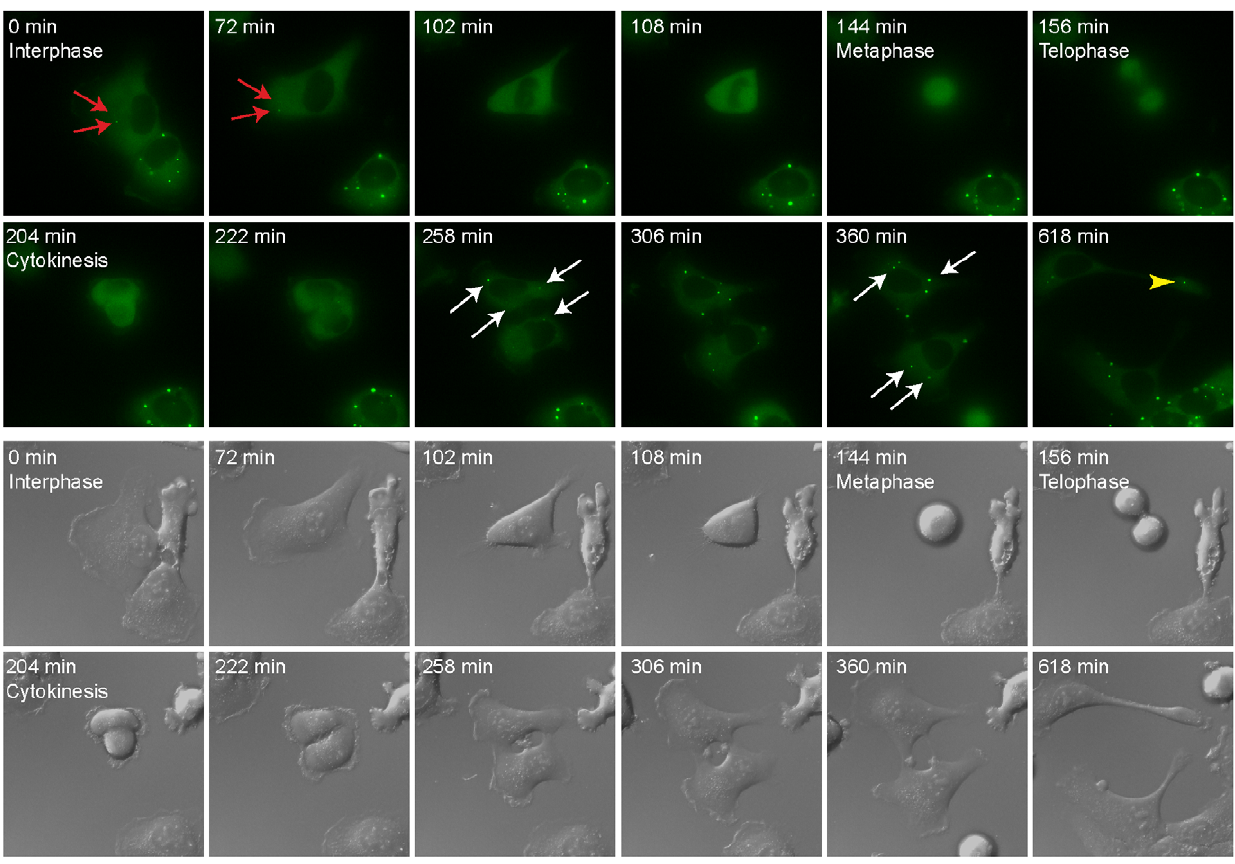
Figure 2. PB assembly and disassembly during cell division in living cells. Cells stably expressing GFP-Dcp1a were simultaneously imaged in GFP and DIC showing the assembly and disassembly of PBs from a movie acquired for 14 hours. Cells were imaged every 6 min. Red arrows: PBs in the cell before mitosis. White arrows: PBs in daughter cells after mitosis. Yellow arrow head: PB in a retraction fiber.